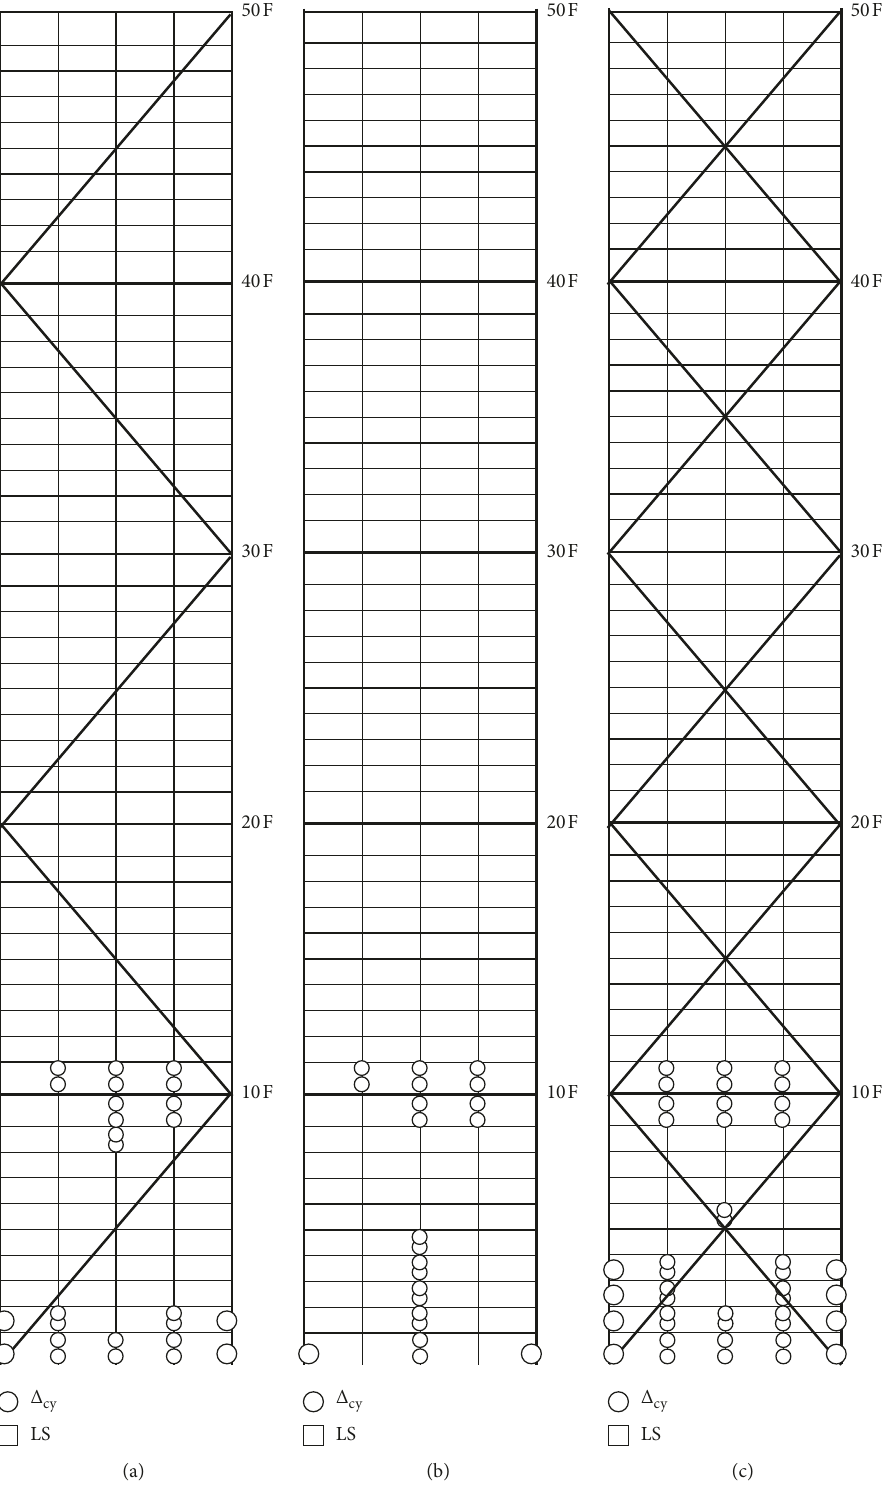
2%: (a) 5MBC model; (b) 5MC model; (c) 5MXBC (cid:30)